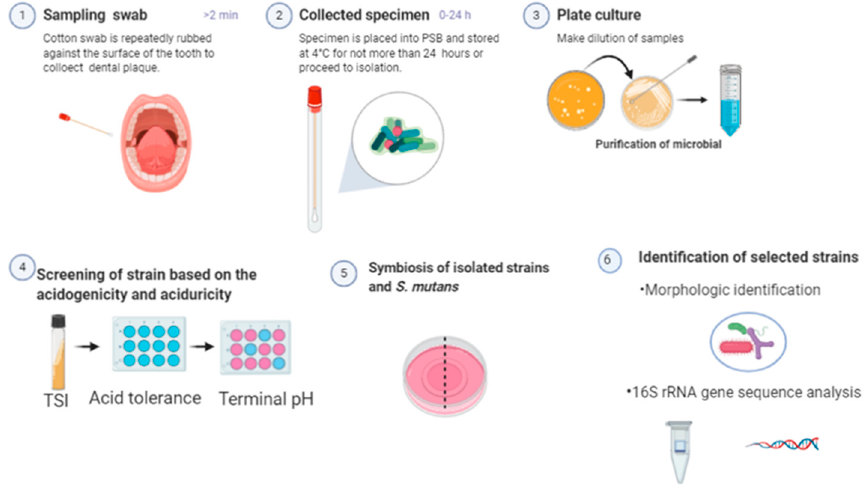
Figure 1. The process of isolation and screening of potentially cariogenic microorganisms in human teeth biofilms. TSI: triple sugar iron agar; PSB: protein solubilization buffer; S. mutans : Streptococcus mutans .